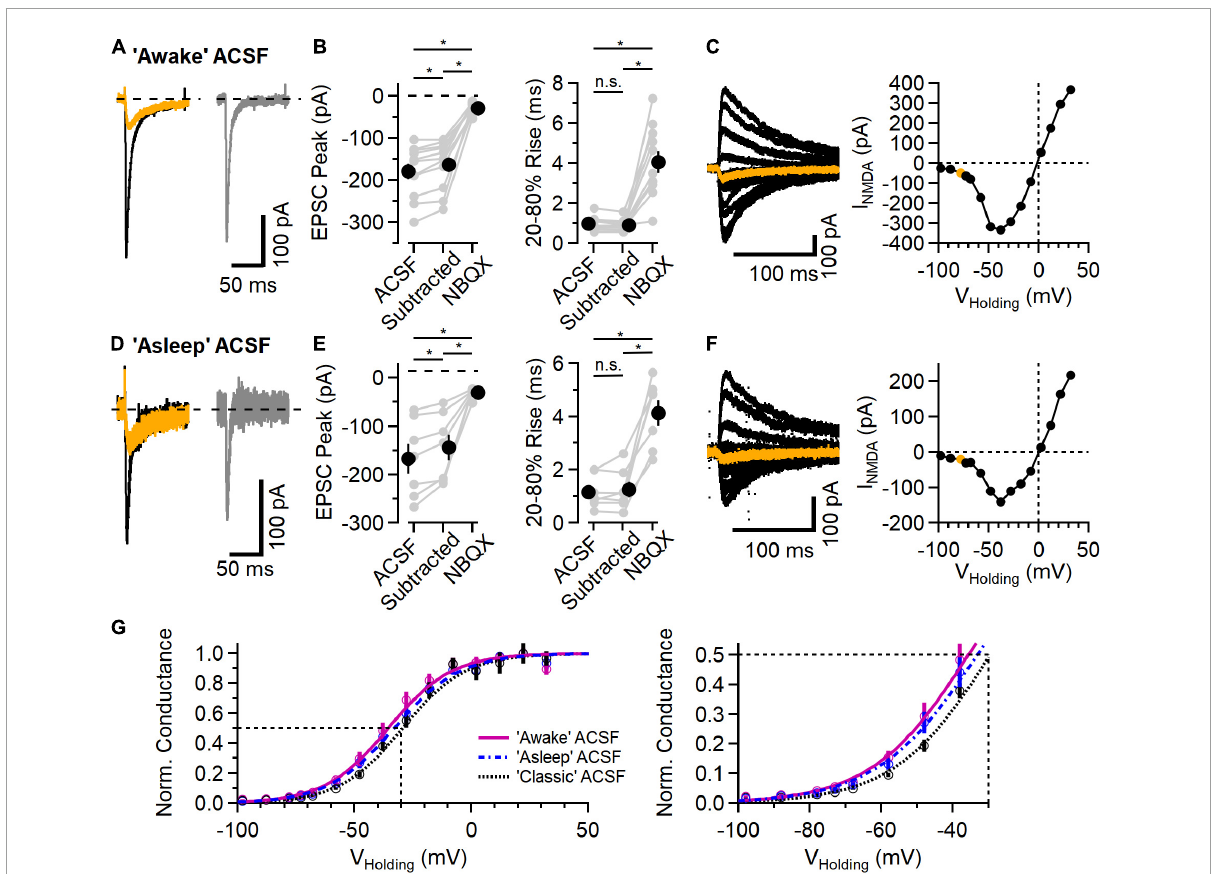
FIGURE3 NMDAR component of the EPSC in L2/3 neurons in physiological ionic conditions. (A) EPSC measured in “awake” ACSF (1.2 mM Ca 2 + /0.7 mM Mg 2 + /4.2 mM K + ), before (black trace) and after addition of 10 µ M NBQX (orange trace), and the subtracted (NBQX-sensitive) AMPAR component (gray trace). (B) Left, NBQX-subtracted traces show a significant contribution of NMDAR current to EPSC peak measurement at a holding potential of –78 mV [Friedman test statistic = 21.0 (6.6), p = 2.7E-5; comparing ACSF condition versus subtracted condition, p =